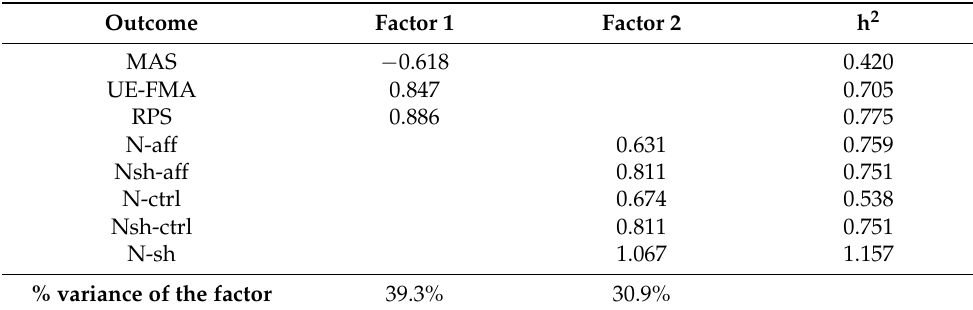
Table 4. EFA0, with promax rotation for variables at T0.